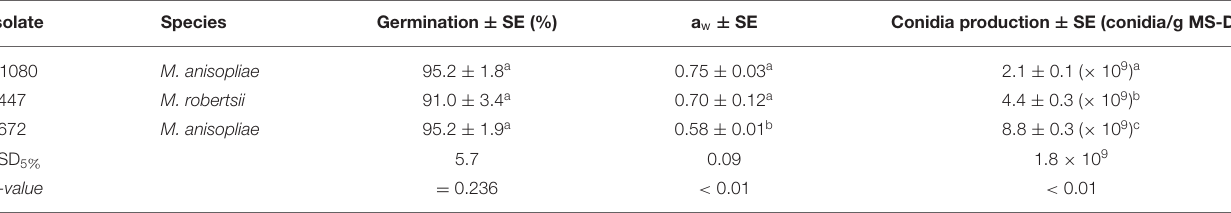
TABLE 2 | Characterization of Metarhizium spp. micr o sclerotia–diatomaceous earth granules.